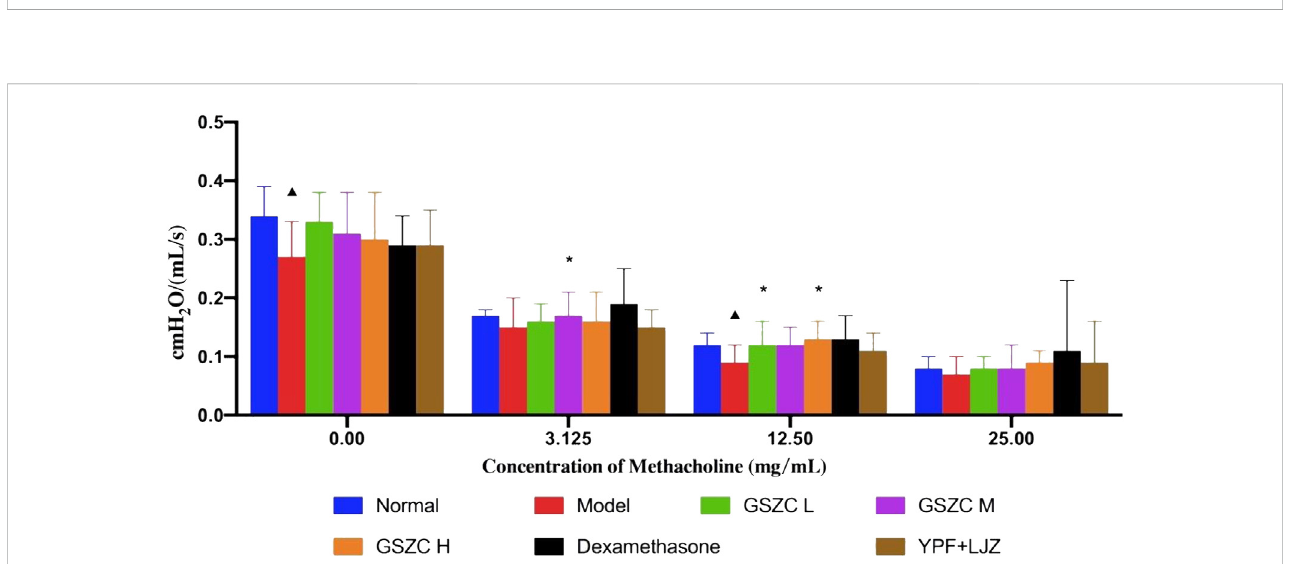
FIGURE 3 EffectsofGSZCgranulesonairwaycomplianceinratssufferingfromasthma.Valuesarethemean±SD,n=10foreachgroup. ▲ p < .05 versus thenormal group, * p < .05 versus the model